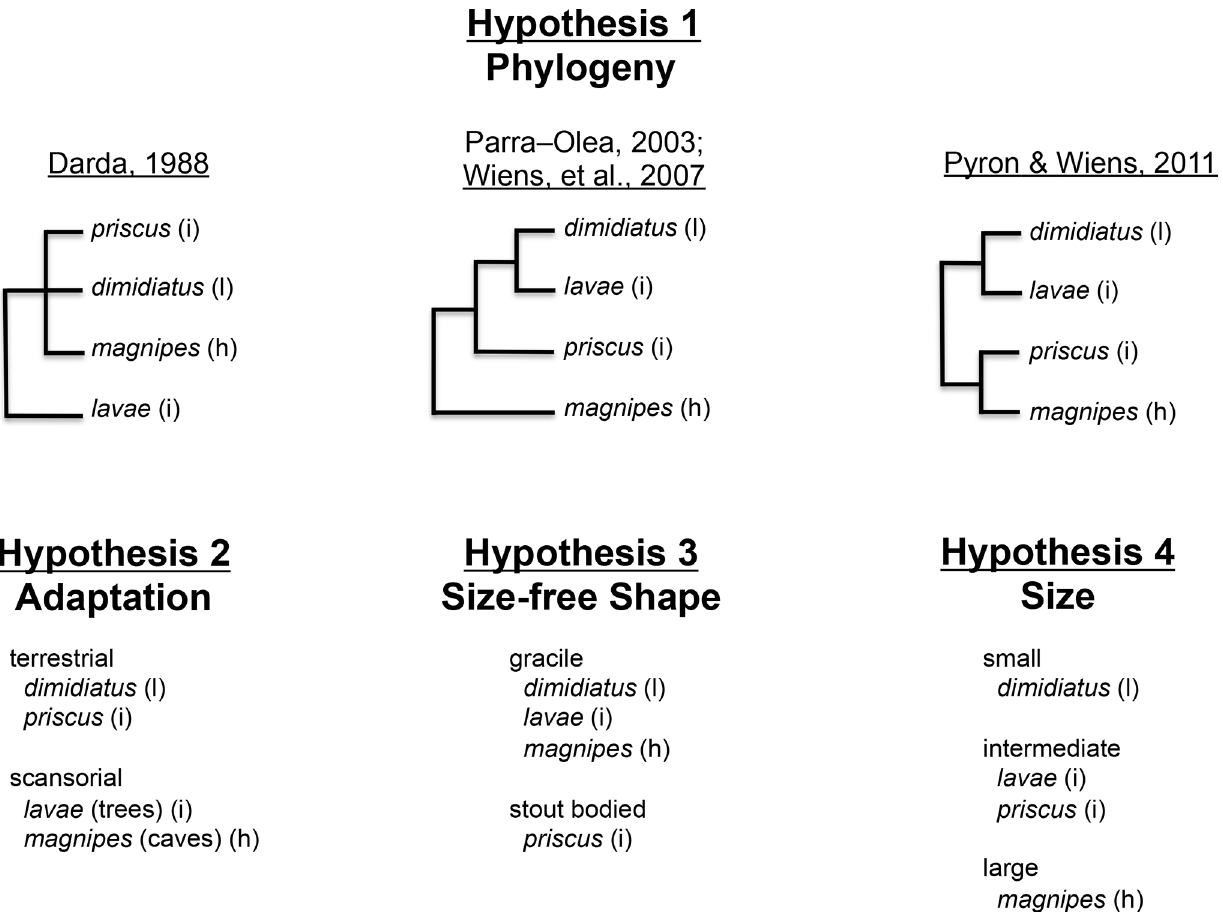
Fig 15. Skull robustness hypotheses. Four hypotheses representing potential explanations of the pattern of skull robustness seen in the four species of Chiropterotriton examined in this study and the morphological groupings predicted by each hypothesis. Skull robustness: l = low, i = intermediate, h =